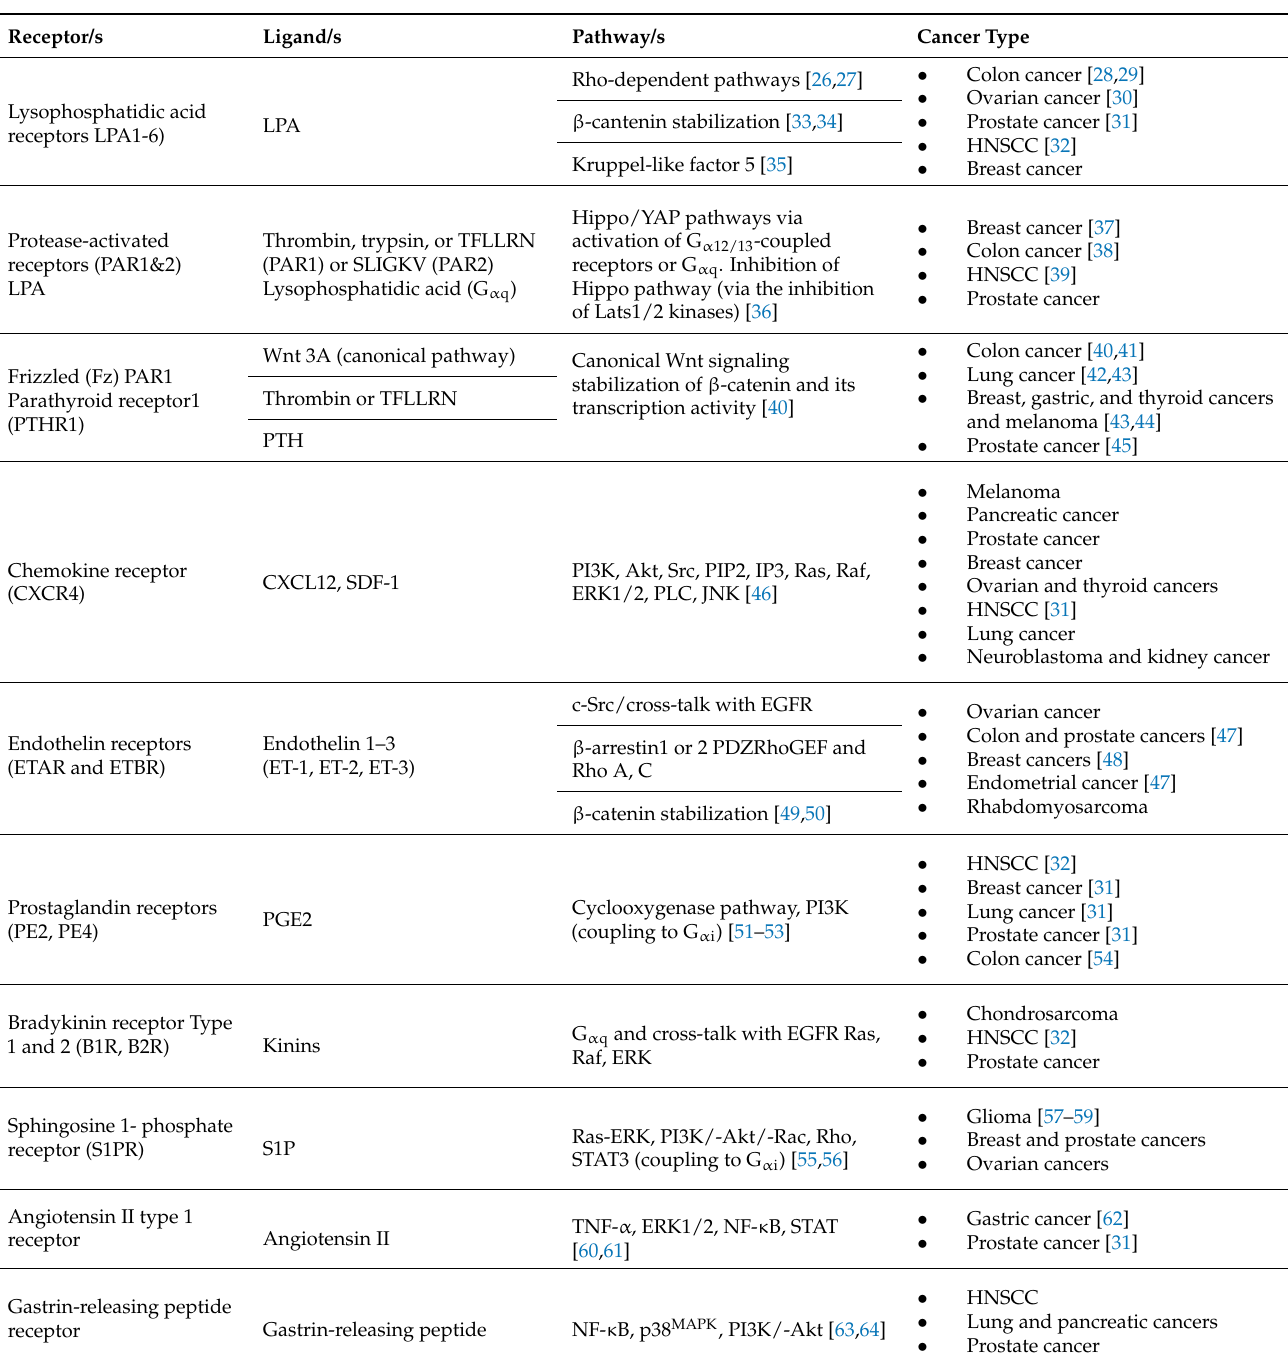
Table 1. Selected G-protein-coupled receptors, ligands, and signaling pathways involved in cancer. Adapted and modified from Bar-Shavit et al.